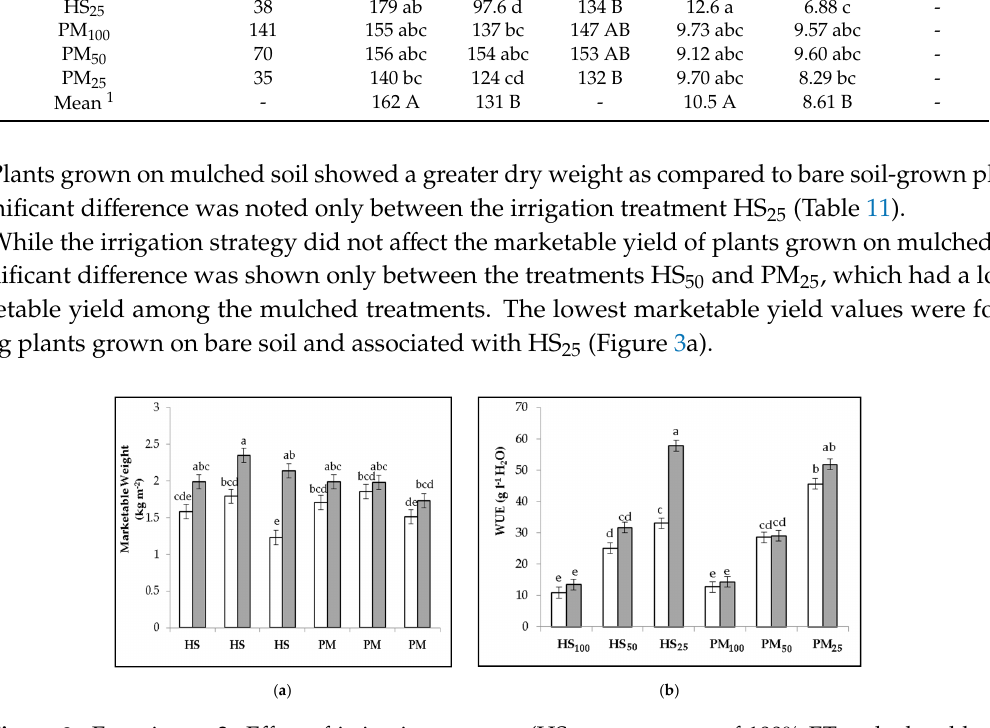
Table 11. Experiment 3: Effect of the interaction between irrigation strategy and soil mulching on the productive parameters of lettuce. Different letters indicate significant differences in the Tukey HSD test ( p ≤ 0.05). Lower case letters indicate differences between treatments; capital letters indicate differences between the means of 1 soil mulching or 2 irrigation strategy factor. Data are the means of three replicates. HS 100 = recovery of 100% ET c calculated by the Hargraves–Samani equation; HS 50 = recovery of 50% ET c calculated by the Hargraves–Samani equation; HS 25 = recovery of 25% ET c calculated by the Hargraves–Samani equation; PM 100 = recovery of 100% ET c calculated by the Penman–Monteith equation; HS 50 = recovery of 50% ET c calculated by the Penman–Monteith equation; HS 25 = recovery of 25% ET c calculated by the Penman–Monteith equation. SM = Straw mulching; BS = Bare soil; WUE = Water use efficiency.